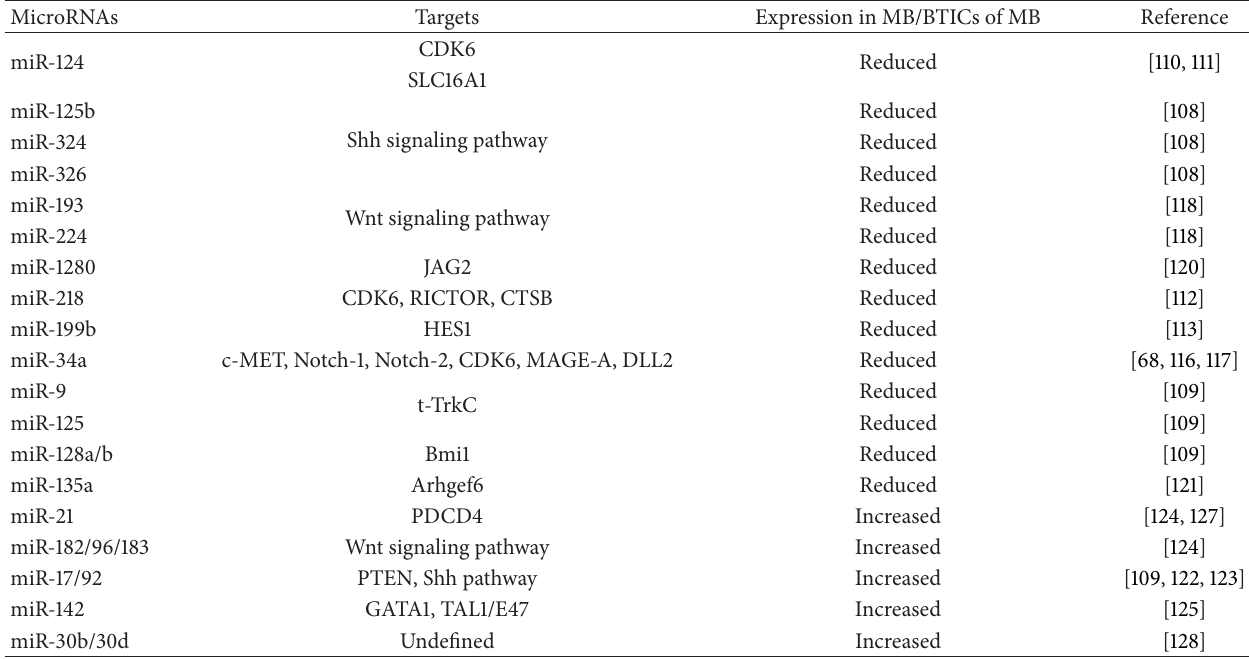
Table 2: miRNAs regulating BTICs in